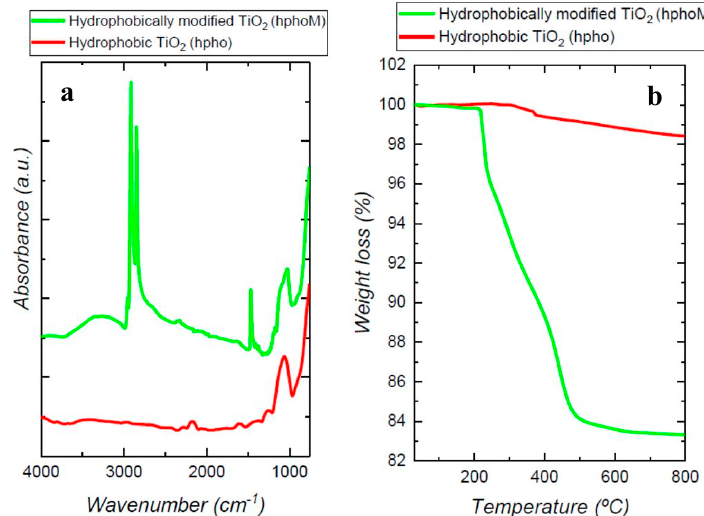
Figure 2. ( a ) Fourier-transform infrared (FTIR) spectra and ( b ) thermogravimetric analysis TGA curves of commercial hydrophobic (hpho) and TMOS modified nanoparticles (hphoM).